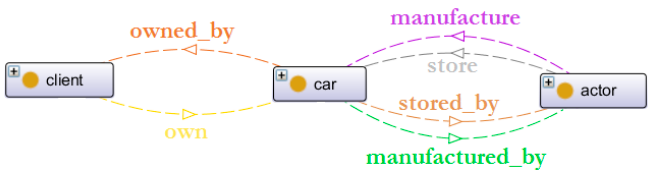
Figure 9. Object properties linking the actors, cars and clients.